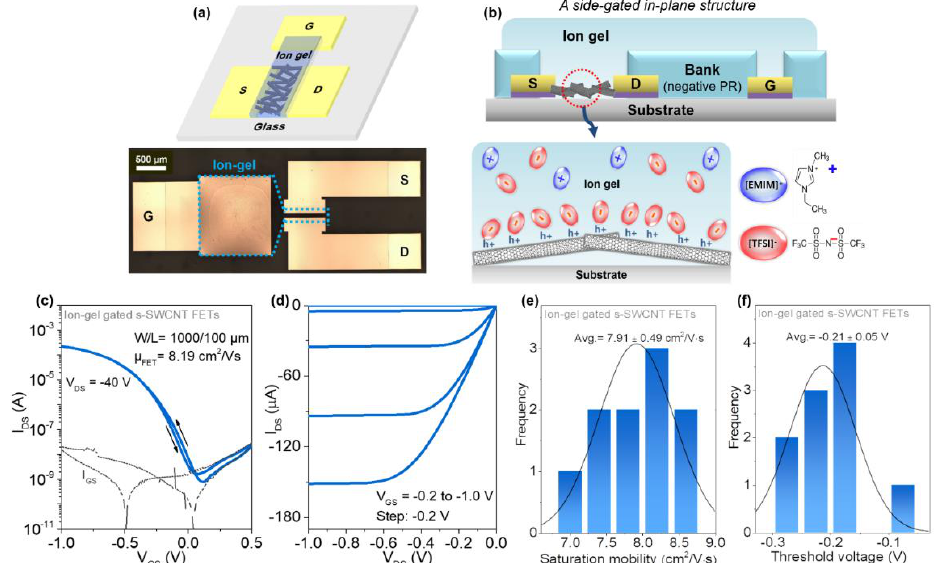
Figure 4. ( a ) Schematic of a side gate high-purity SWCNT FET using ion-gel gate dielectric layer and the optical image of the device (bottom). ( b ) The side view of ion-gel gated SWCNT FET with the channel accumulation by ions in the ion-gel gate dielectric and a chemical structure of EMIM-TFSI. The electrical characteristics: ( c ) a transfer (W/L = 1000/100 μm, V DS = −0.5 V) and ( d ) output curves of ion-gel gated SWCNT FET. Statistics data for ( e ) saturation mobility and ( f ) threshold voltage.